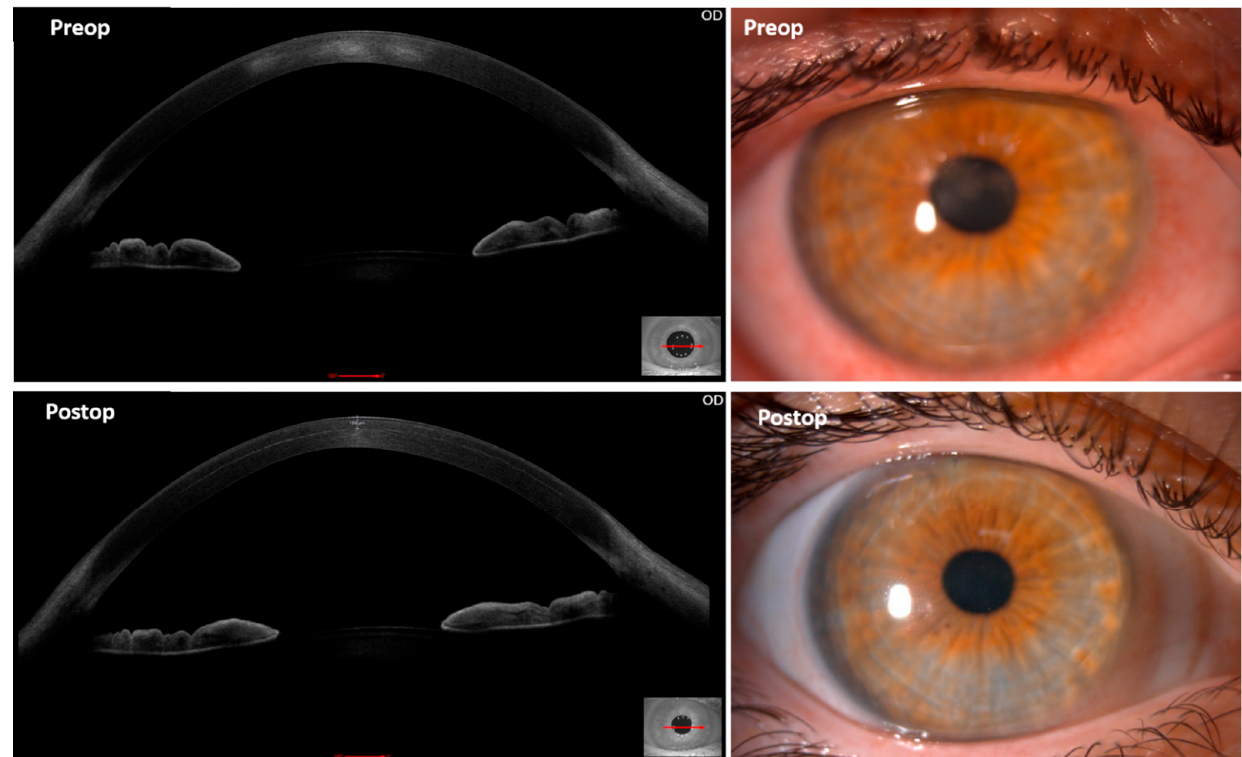
Figure 4. Anterior segment OCT and slit-lamp images from a keratoconus patient before ( up ) and 1 month after ( down ) autologous mid-stromal ADSC implantation. Observe the postoperative improvement in the density and severity of the central preoperative scars both clinically and in OCT. The ADSC intrastromal deposit of new collagen can be already observed 1 month after surgery in this case ( down-left image